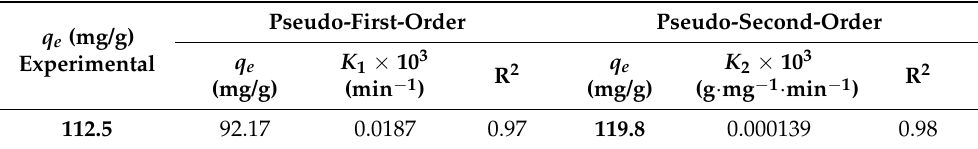
Table 4. Detected kinetics parameters for adsorption of Na + at C o = 10,000 mg · L − 1 , 27 ◦ C, pH = 4 for 150 min. Pseudo-First-Order q e (mg/g) Experimental